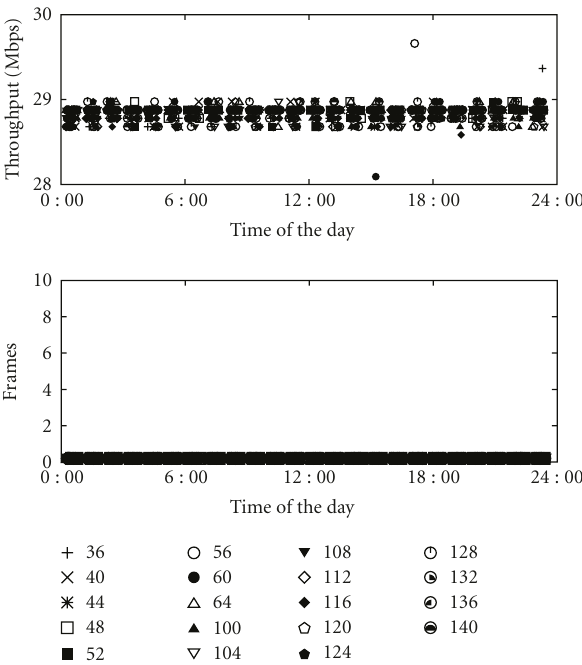
Figure 6: Performance of 802.11a in our testbed for each.